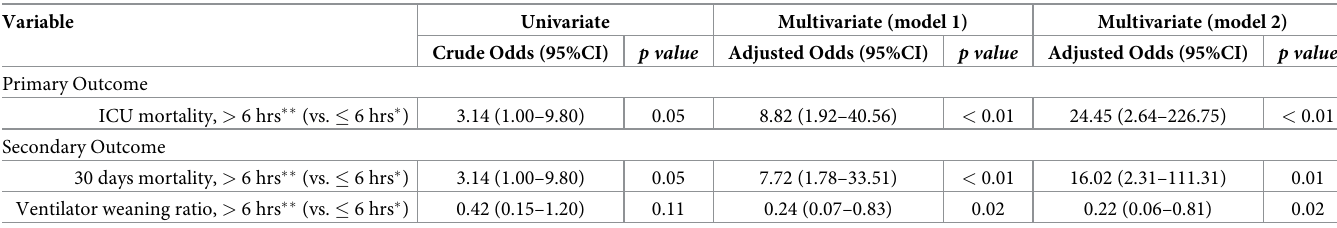
Table 2. Odds of primary and secondary outcome.